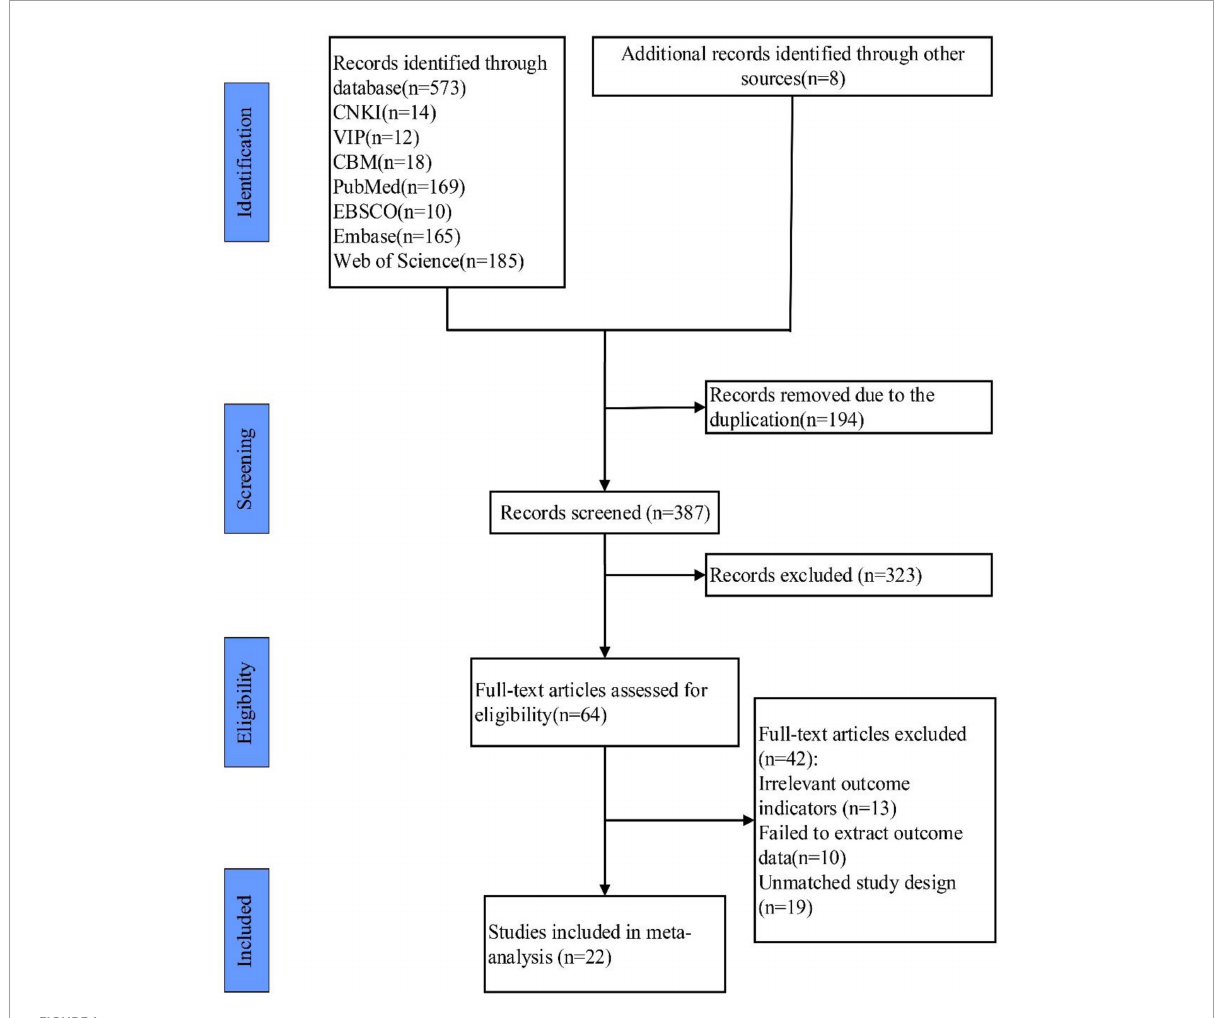
FIGURE1 Study selection represented by PRISMA